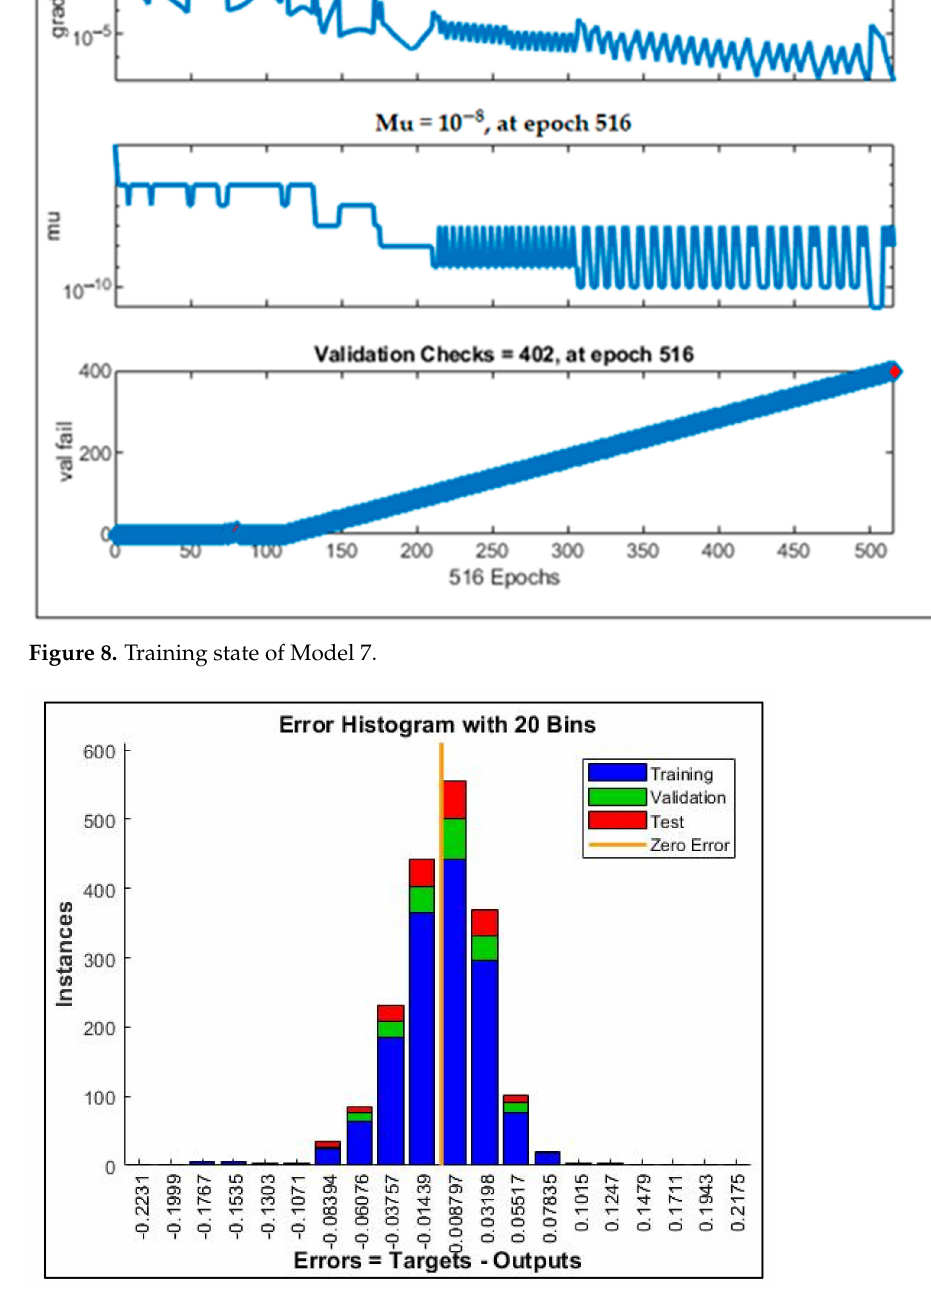
Figure 9. Error histogram of Model